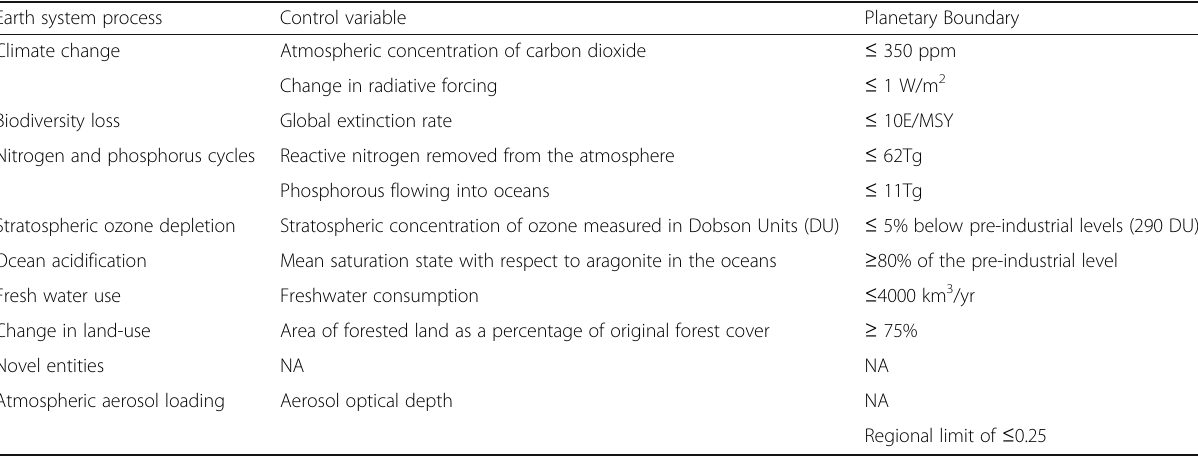
Table 1 Summary of the Planetary Boundaries (adapted from Steffen et al. [12], Table 1) Earth system